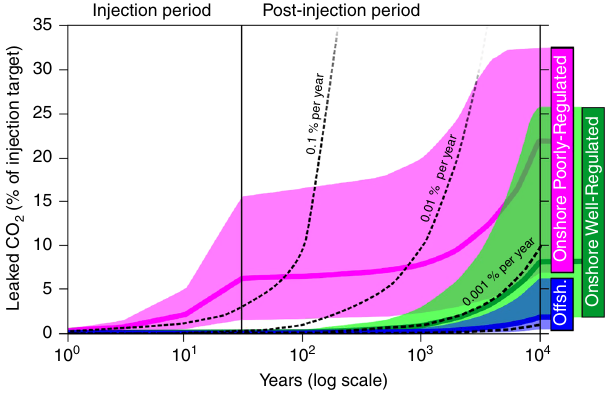
Fig. 4 Monte Carlo runs of the three scenarios. The graphs show cumulative leakage of CO 2 as a percentage of the total injected. Each scenario shows the P50 output as a blue, green, or magenta line, with shading above showing the P05 limit, and below for the P95 limit, de fi ning occurrence envelopes for the three scenarios. These are calculated on 12 Gt CO 2 injected between 2020 – 2050, with subsequent storage and leakage over 10,000 years. Black dotted lines show comparisons based on time averaged yearly constant leak rates for 0.1, 0.01, 0.001 and 0.0001% per year (the latter represented by the unlabelled dotted line at the base of the diagram). Offshore Well-Regulated storage (blue) is found to be the most reliable Scenario. Onshore Well-Regulated storage (green) exhibits higher leakage due to a higher density of abandoned wells acting as potential leakage pathways. Poorly-Regulated Onshore storage (magenta) exhibits the highest leakage rates in the short term due to the prevalence of unidenti fi ed abandoned wells that are unplugged or